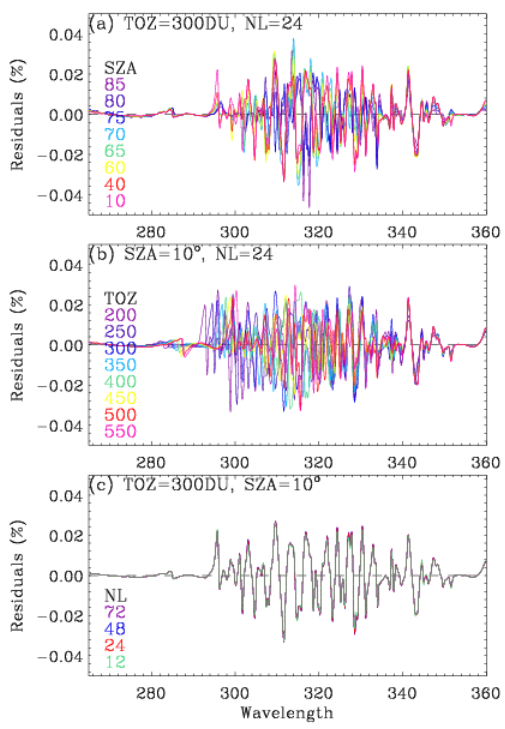
Figure 6. Residuals (%) of the PCA-RT radiances with the bin- ning scheme given in Table 1 for various sets of (a) SZAs at VZA = 30 ◦ and AZA = 120 ◦ , (b) ozone profiles with different total ozone columns (TOZs), and (c) number of atmospheric